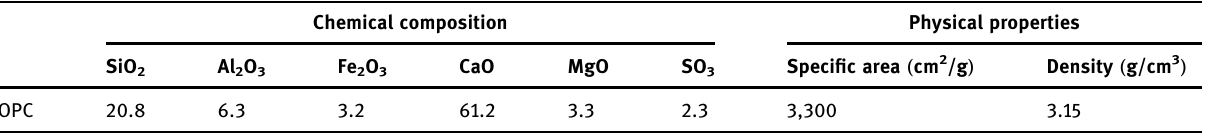
Table 1: Chemical composition and physical properties of OPC